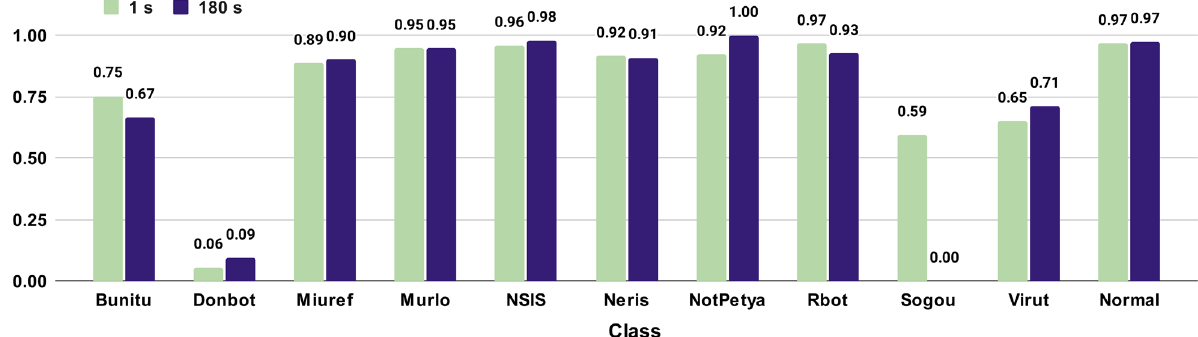
Figure 2. F1 scores per traffic class using time windows of either one second or 180 seconds.